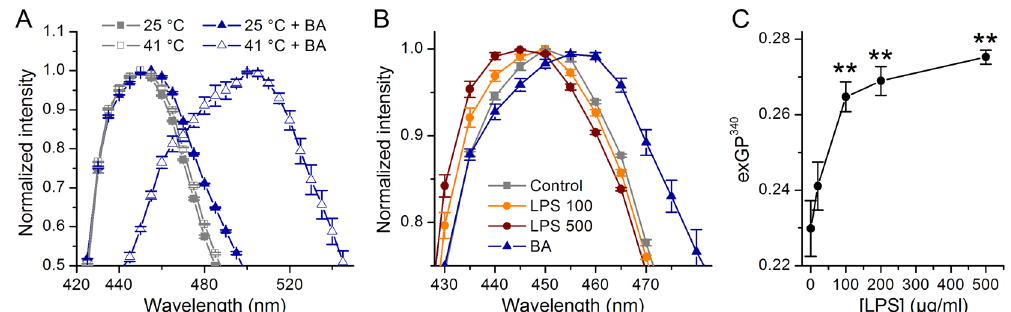
Figure 3. Effects of E . coli LPS on Laurdan’s emission spectrum in DPPC GUVs. ( A ) Laurdan spectra obtained at 25 °C and 41 °C in control and after treatment with BA (100 mM, 10 min). ( B ) Laurdan spectra recorded at 37 °C in control and after treatment with E . coli LPS (100 µ g/ml or 500 µ g/ml) or 100 mM of BA. ( C ) Laurdan exGP 340 determined at 37 °C, as function of E . coli LPS concentration. Data from at least 3 samples performed at least in triplicate. ** P < 0.01; Mann-Whitney U